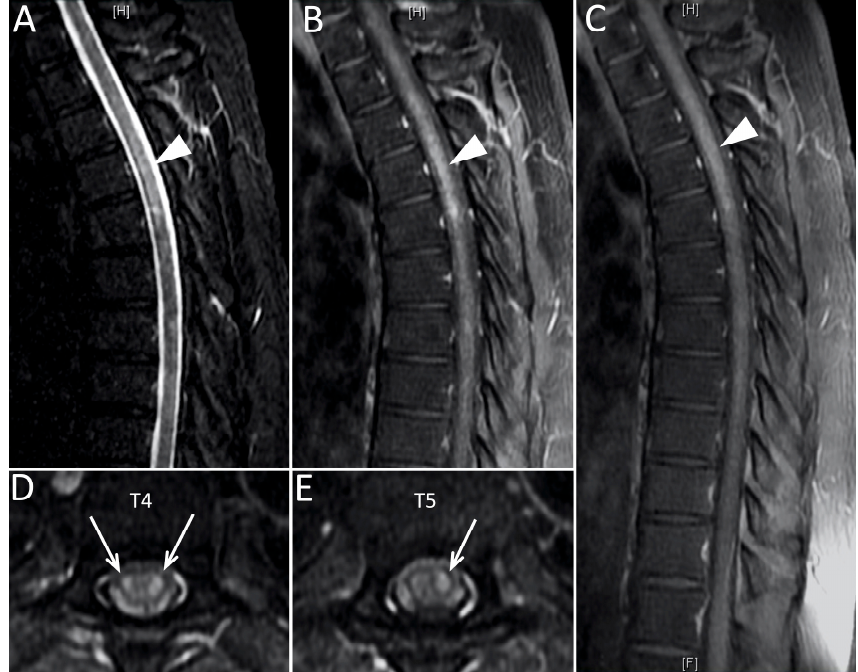
Figure 1. The MRI of the thoracic spine on the T2 ‐ weighted short tau inversion recovery scan ( A ) showed a hyperintense lesion on T1 ‐ T6 (indicated by arrowheads). The lesion was enhanced in the early ‐ phase contrast ‐ enhanced T1 ‐ weighted fast spin echo scan ( B ) and post ‐ contrast T1 ‐ weighted fast spin echo scan ( C ). The axial view of the post ‐ contrast T1 ‐ weighted fast spin echo scan over T4 ( D ) and T5 ( E ) revealed the enhanced lesion in the spinal cord (indicated by arrows).